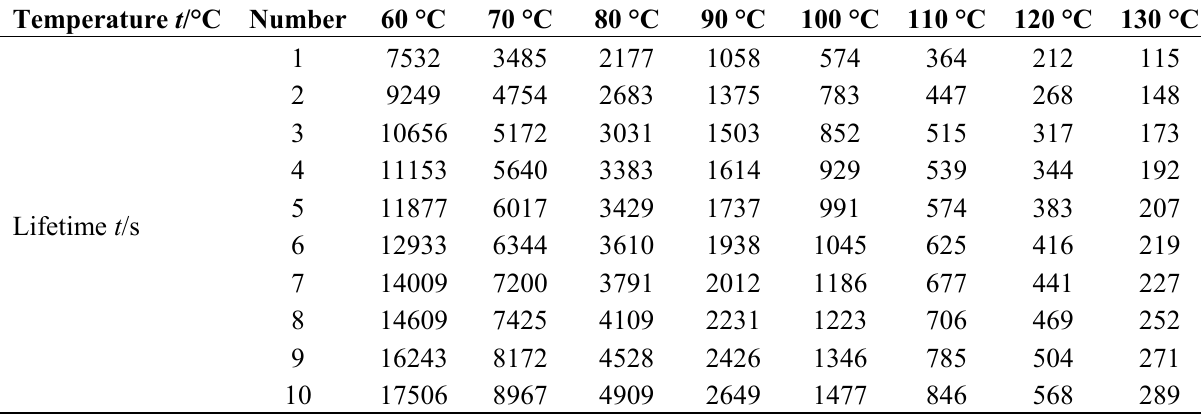
Table 1. Test data of the samples at 9.5 kV under different